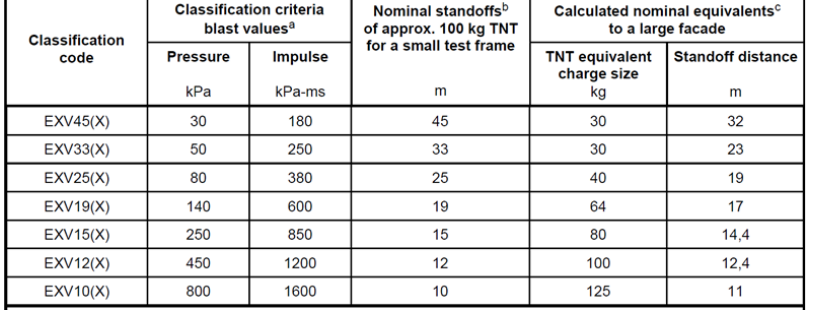
Table 4 =: Hazard rating